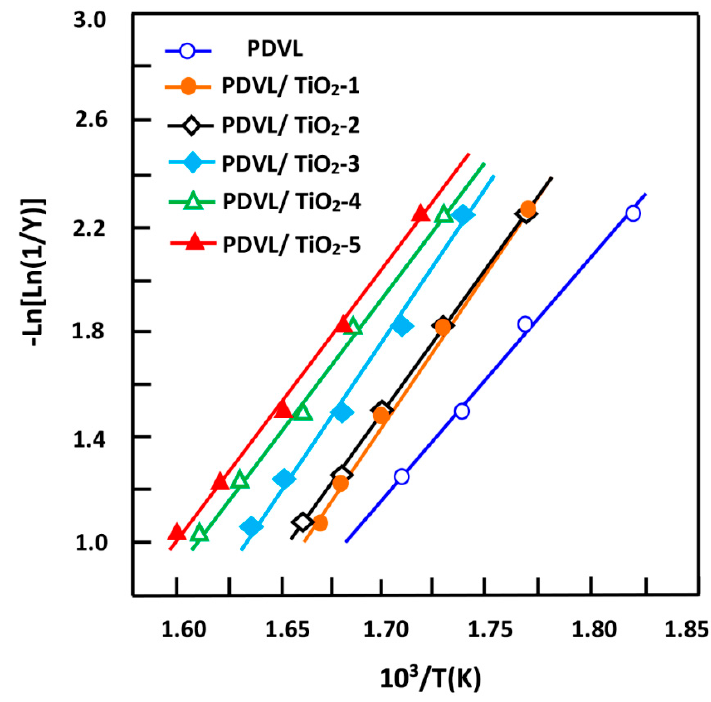
Figure 15. Variation of Ln [ Ln (1/ Y )] versus the reverse of temperature for pure PDVL and PDVL/TiO 2 nanocomposites containing different TiO 2 contents.